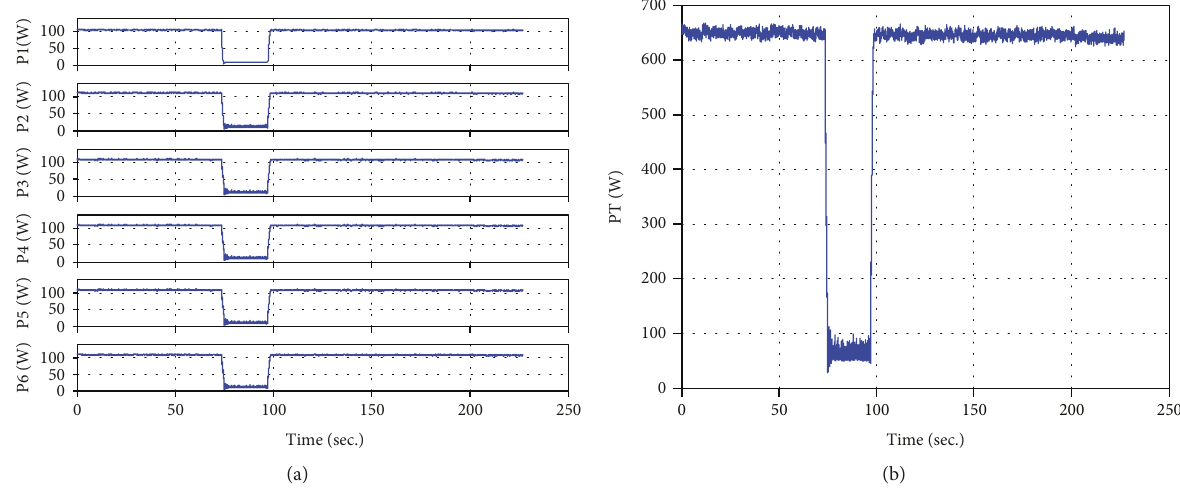
Figure 21: (a) Nondistributed MPPT control of PV modules under shading. (b) Total power extracted from the whole PV modules.